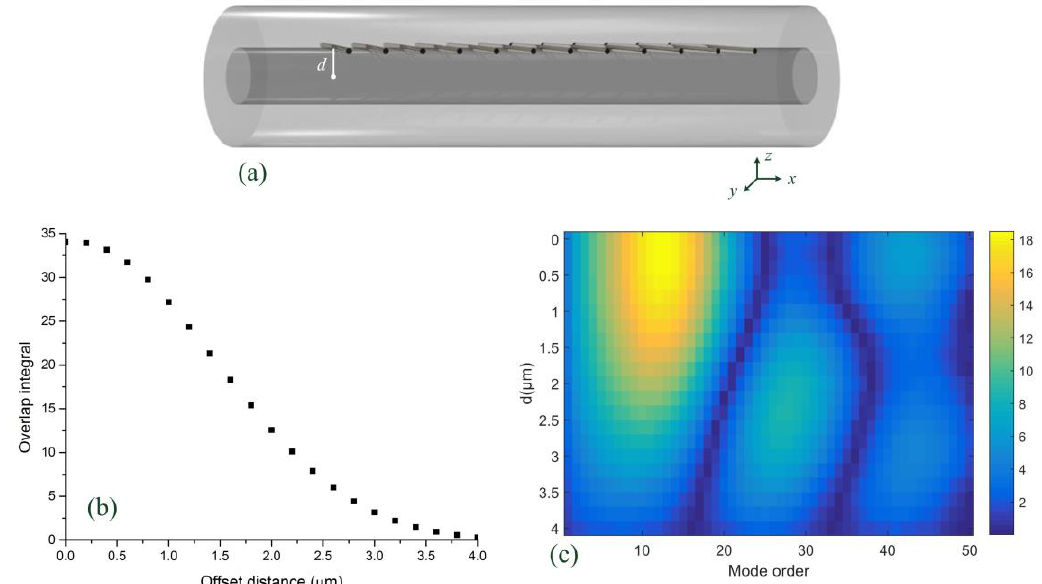
Figure 3. ( a ) Schematic of TFBG with offset distance d . ( b ) Overlap integral of fundamental mode versus offset distance. ( c ) Overlap integrals of the first 50 cladding modes under different offset distance.